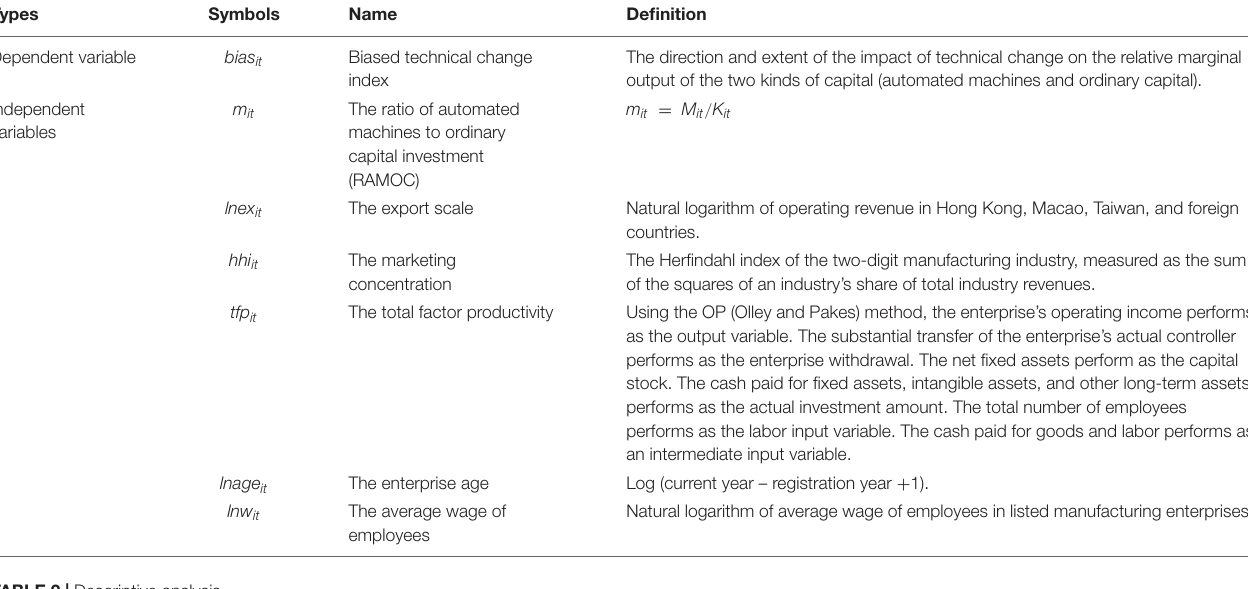
TABLE 2 | Descriptive